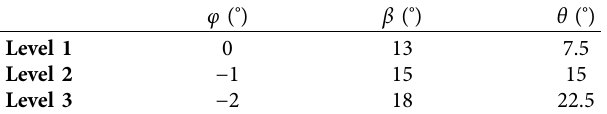
Figure 6: The maximum electromagnetic torque versus turn-off angle for different turn-on angle. (a) θ � 7 . 5 ° . (b) θ � 15 ° . (c) θ � 22 . 5 ° . Table 2: Experimental factors and levels.